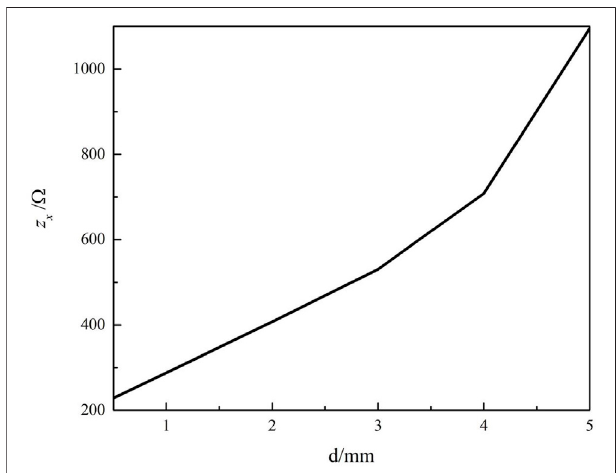
FIGURE 2 | Surface impedance of SSPP corresponding to different groove depth